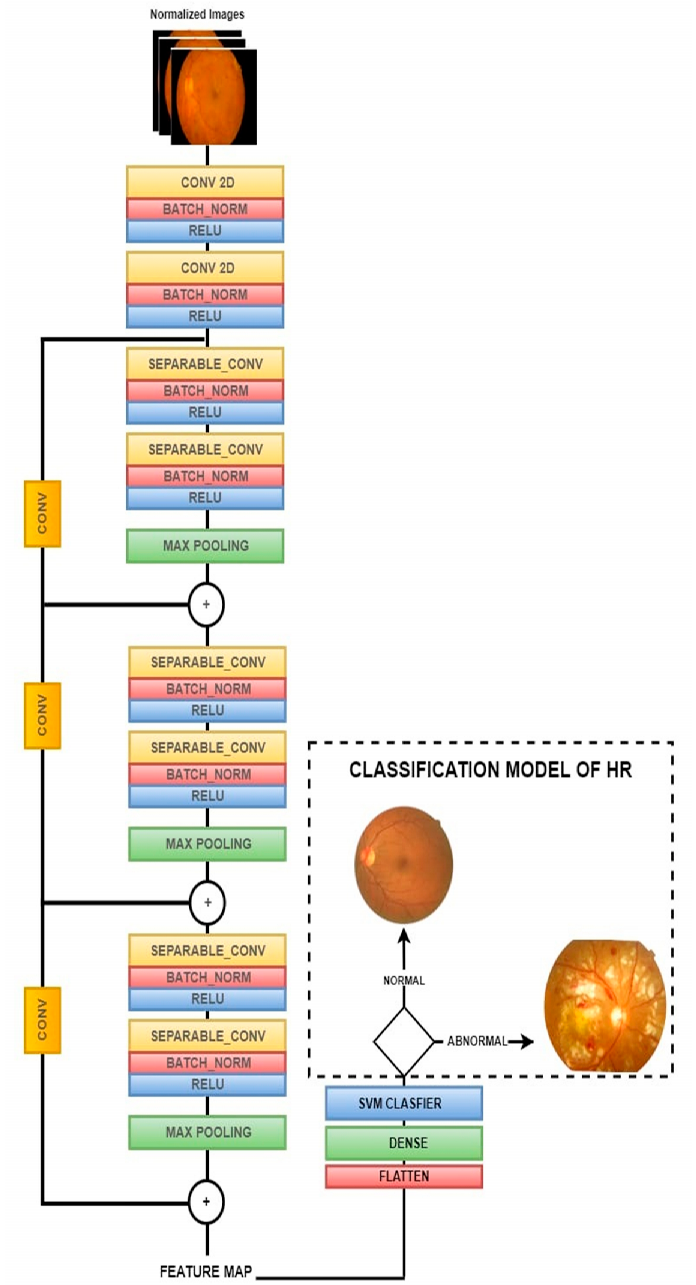
Figure 7. A visual representation of the proposed CAD-HR-diagnosis system utilizes a DSCNN, residual connections and LSVM to extract features and classify them for HR stage